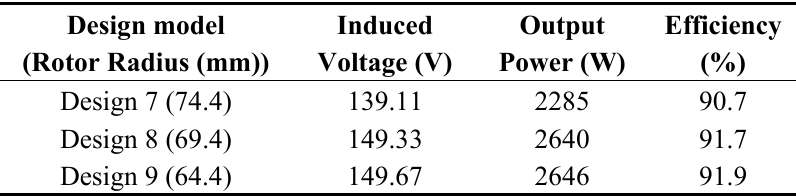
Table 5. Output power and